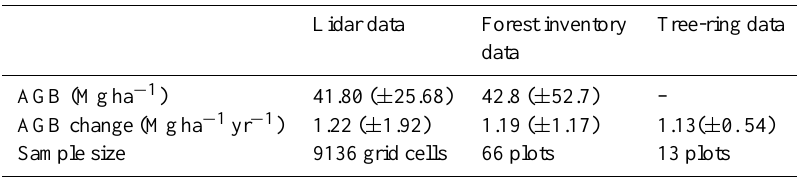
Figure 4. Simulation model results for AGB over a 100-year period without fire (a) and at annual fire probability of occurrence of p = 0 . 002 (b) , 0.004 (c) and 0.01 (d) . Figures show mean (black line) and 95% confidence intervals (grey shading). Table 2. Comparison of the lidar modelling of above-ground biomass (AGB) and biomass change (AGB change) with forest inventory and tree-ring data: values given are mean (and standard deviation in